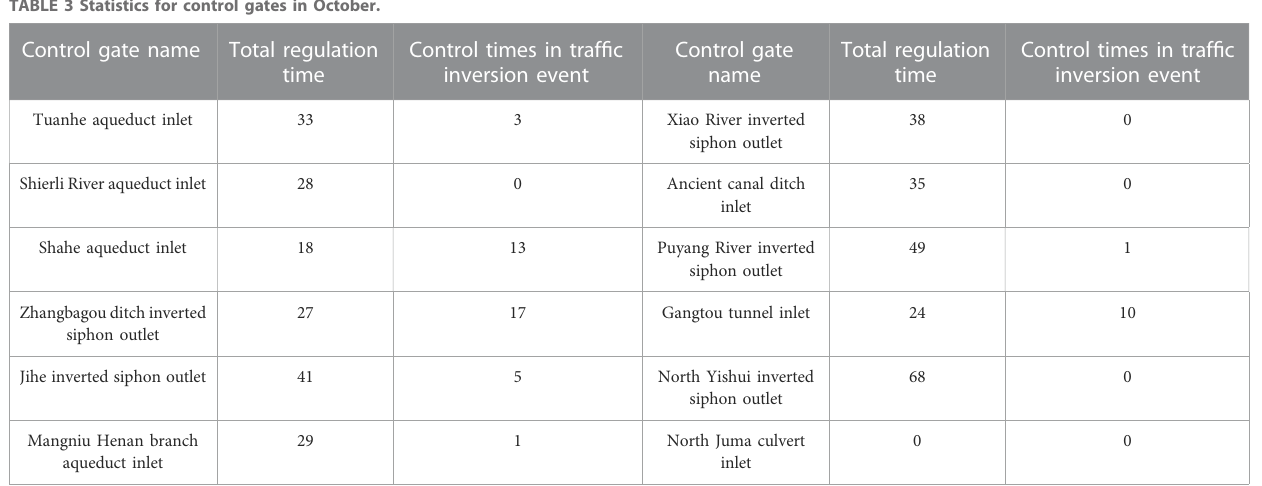
TABLE 3 Statistics for control gates in